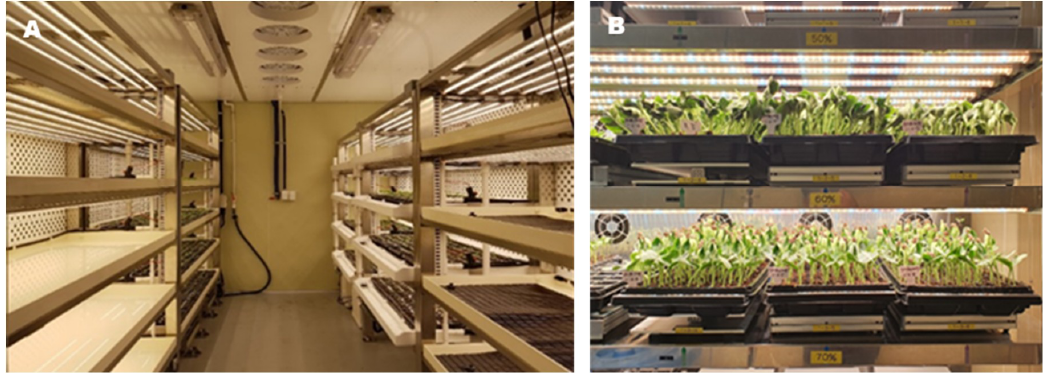
Figure 1. Plant factory with artificial lighting (PFAL) for seedling production ( A ) and cucumber scions and rootstocks on load-cells installed in PFAL ( B ).